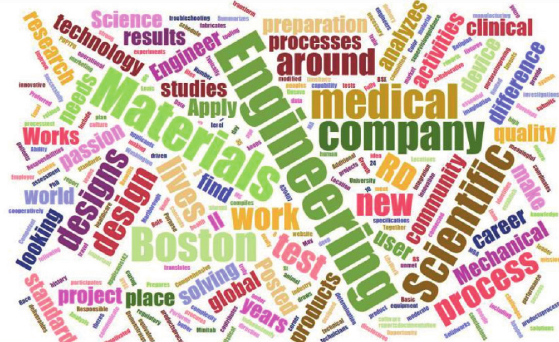
Figure 9: Case study diagrams generated from job requirements, with skill words